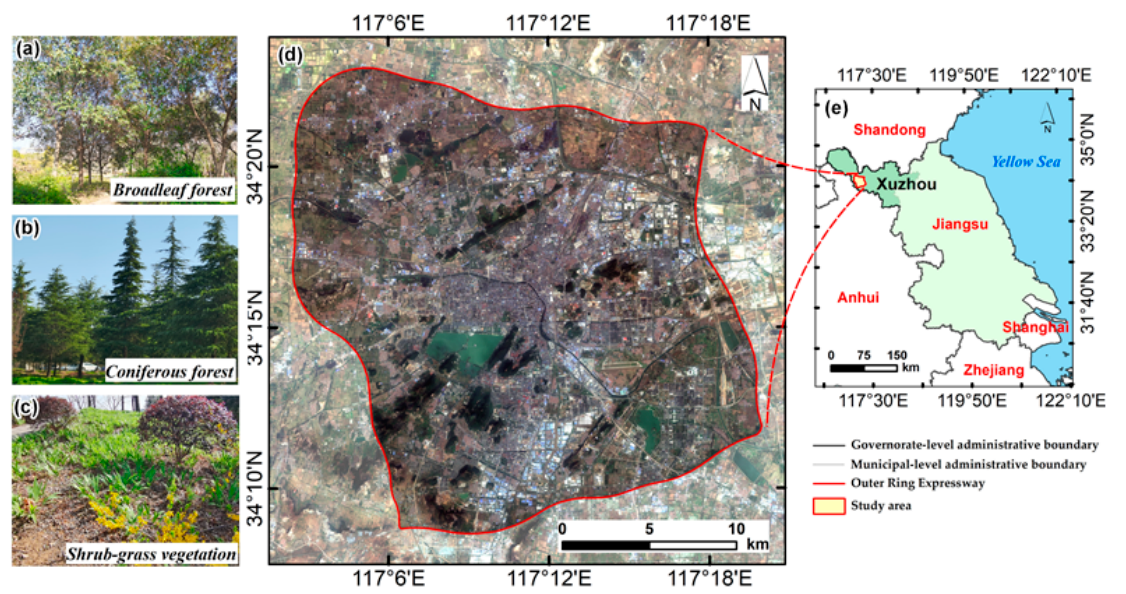
Figure 1. Study Area: ( a – c ) field photos illustrating three typical UGS types; ( d ) the scope of the study area (i.e., within the outer ring expressway around Xuzhou); ( e ) Xuzhou City in northern Jiangsu Province, eastern China.